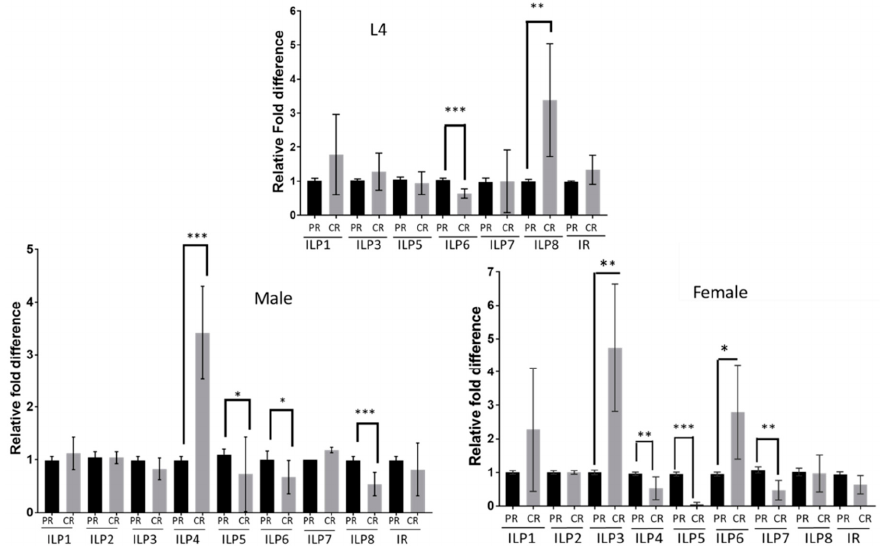
Figure 1. Transcript levels of insulin-like peptides in L4 and adult mosquitoes from larvae reared on different diets. ILPs transcript levels were determined by qRT-PCR in larval instar four (L4, top) male (left) and female (right) adults eclosed from the larvae reared either on PR or CR diet. PR diet fed samples were used as a control for the relative transcript expression determination. Significant